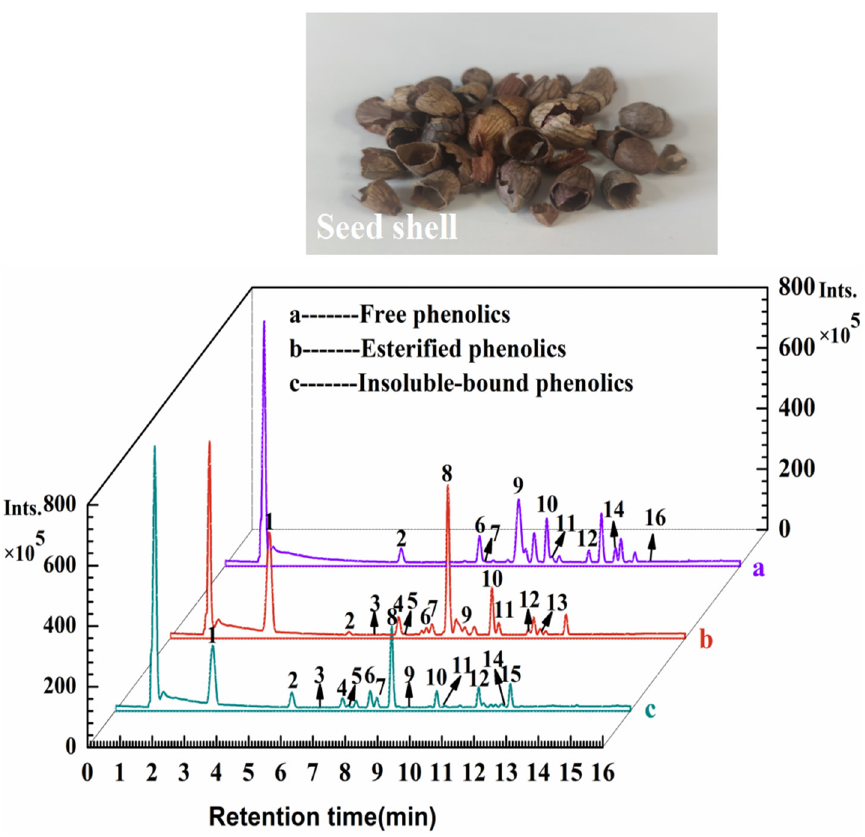
Figure 2. Basal peak chromatograms of the TF ( a ), TE ( b ), and TI ( c ) extracts from the seed shell of Prinsepia utilis Royle.